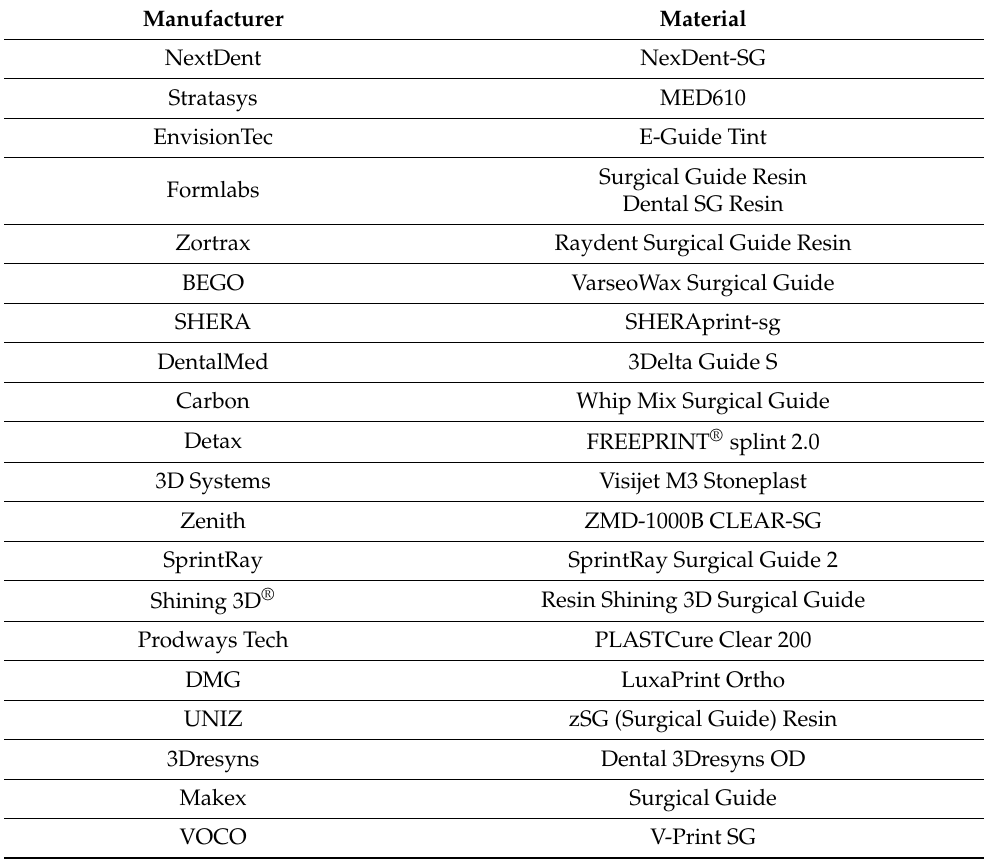
Table 3. List of three-dimensional (3D) surgical guide materials (resin) from